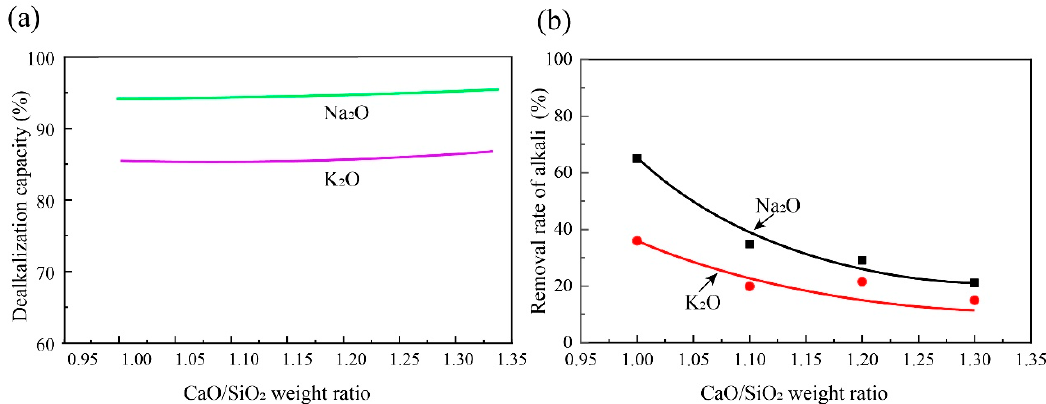
Figure 8. Effect of the CaO/SiO 2 ratio on the removal of alkali at slag-to-metal ratio of 200 kg/t, ( a ) FactSage calculation, ( b ) experimental results.